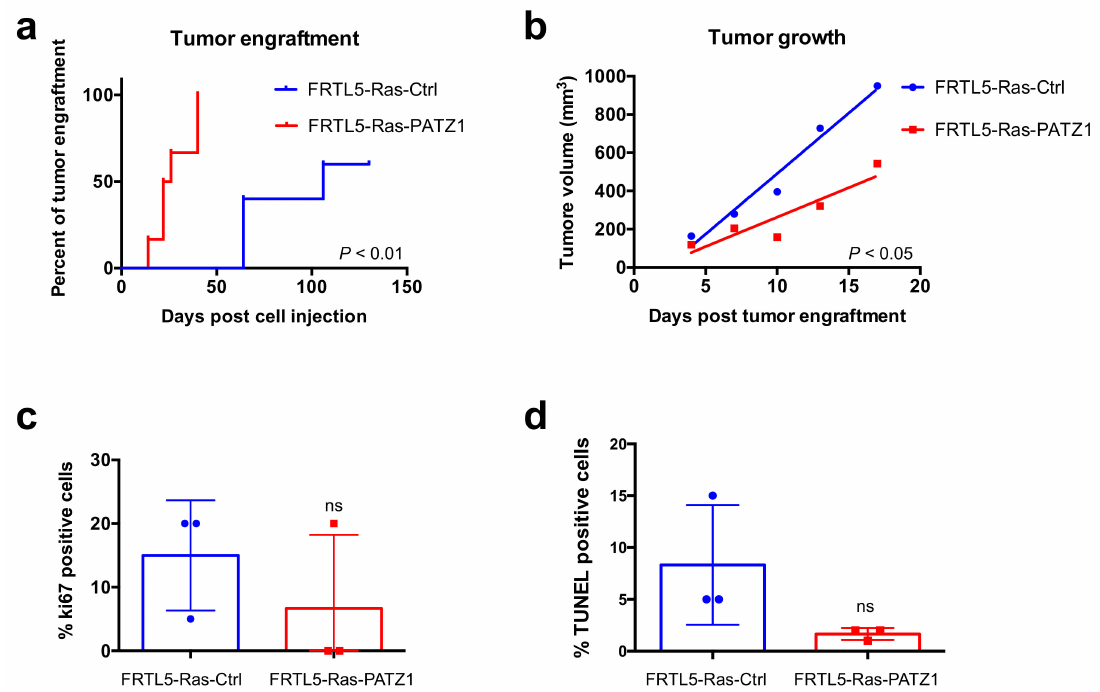
Figure 1. PATZ1 enhances tumor engraftment of FRTL5-Ras cells but inhibits their growth rate. ( a ) Kaplan-Meier curves analyzing tumor engraftment (first appearance of a palpable mass) in cohorts of 6 or 5 mice/group injected with either FRTL5-Ras-PATZ1 or FRTL5-Ras-Control (Ctrl) cells, respectively. As assessed by Log Rank test, the difference between the curves were highly significant ( P < 0.01); ( b ) tumor growth in the two cohorts of animals, considering the first 17 days post engraftment, was significantly different ( P < 0.05), as assessed by the analysis of linear regression (F = 9.58; DFn = 1; DFd = 6). Mean values ± SE have been used to calculate the slopes. ( c ) Percentage of tumor cells stained positively for Ki67 proliferation marker in FRTL5-Ras-Ctrl and FRTL5-Ras- PATZ1 xenografts. Differences among means were not significant according to the Mann Whitney test ( P = 0.2); ( d ) percentage of tumor cells positive at TUNEL assay. Differences among means were not significant according to the Mann Whitney test ( P = 0.1). ns, not